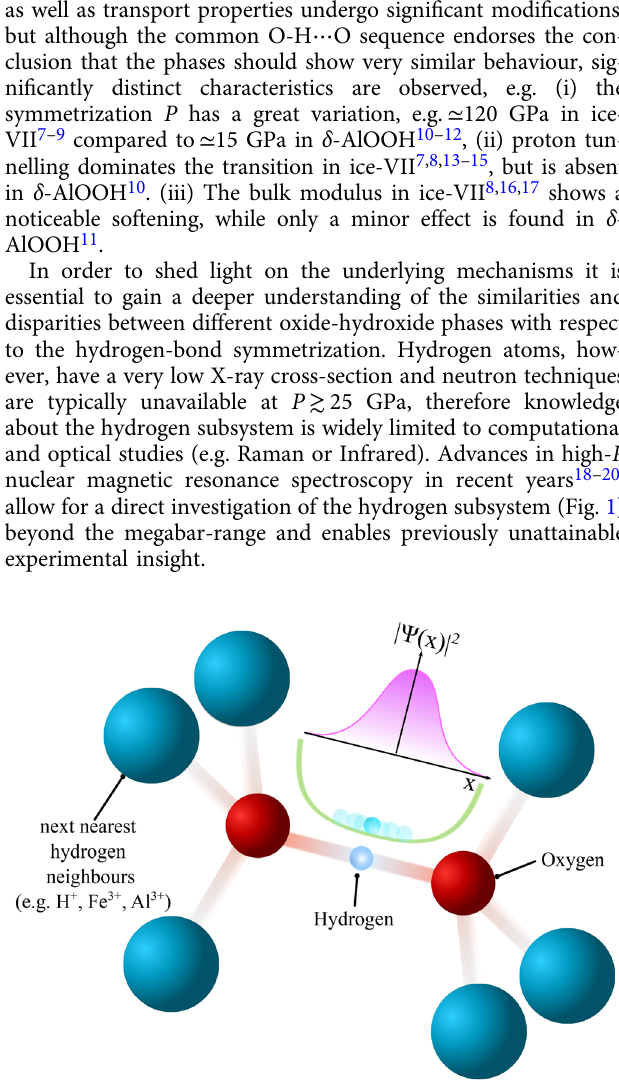
Fig. 1 Structure of hydrogen-bond environments. Schematic representation of the local hydrogen-bond environments with the hydrogen atom at the center. The energy potential of the H-bond (green graph) is determined predominantly by the nearest-neighbour atoms (e.g. oxygen atoms). Depending on initial O-O distances, hydrogen probability distributions, ∣ Ψ ( x ) ∣ 2 , (purple schematic graph) may exhibit uni- or bi- modal characteristics. Shown here is a typical broad energy potential without barrier, leading to an uni-modal probability distribution and thermally activated hydrogen mobility. Next-nearest-neighbours may constitute metal anions, e.g., in hydrous minerals, or other hydrogen atoms in H 2 O